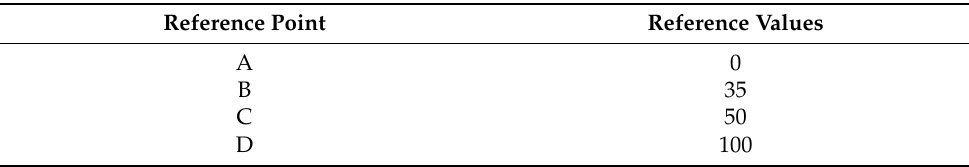
Table 1. Reference point and reference values of premise attribute 1.